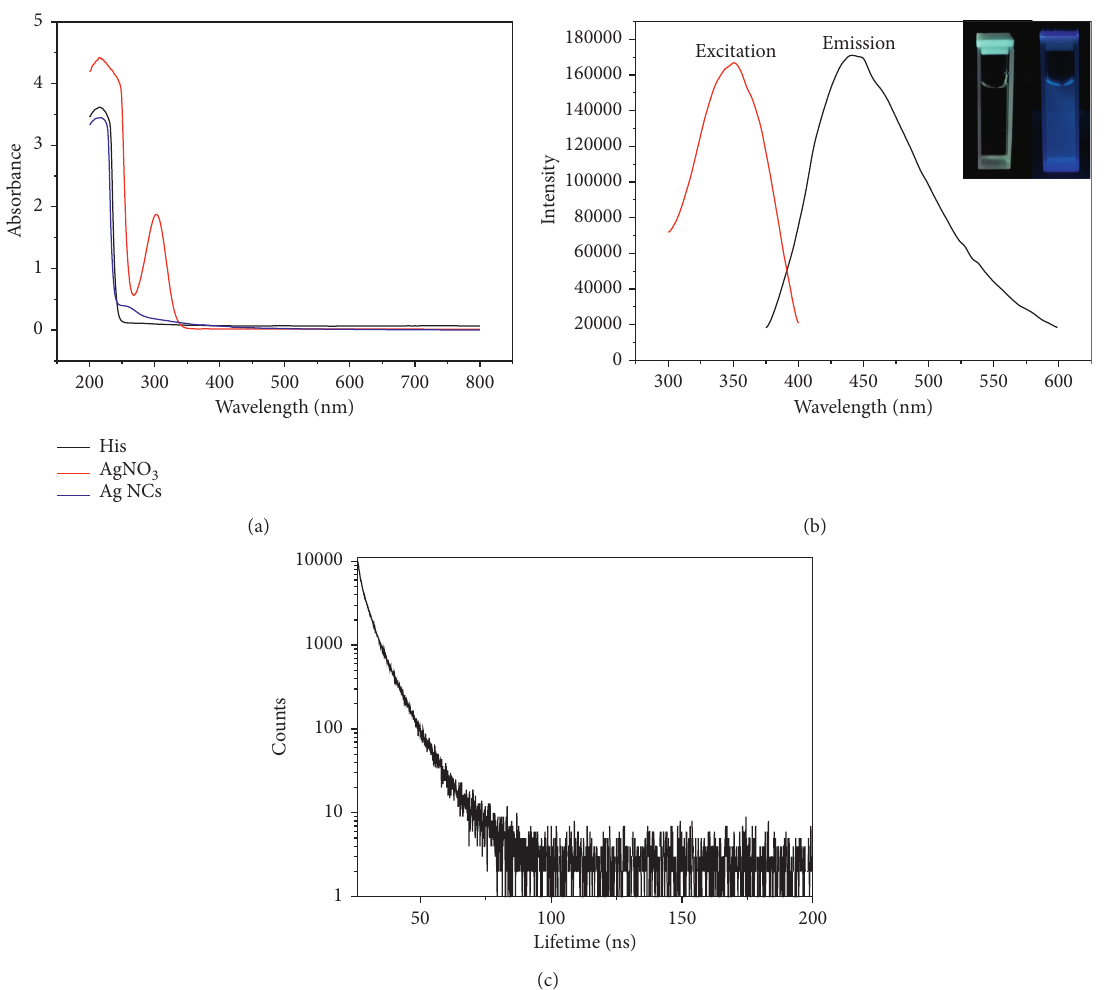
Figure 3: (a) UV-Vis absorption spectrum of His (black), AgNO 3 (red), and the Ag NCs (blue) solution. (b) The PL excitation and emission spectra of the Ag NCs. The inset in (b) is the Ag NCs solution under natural light (left) and under ultraviolet (right). (c) Time-resolved fluorescence spectrum of the Ag NCs.